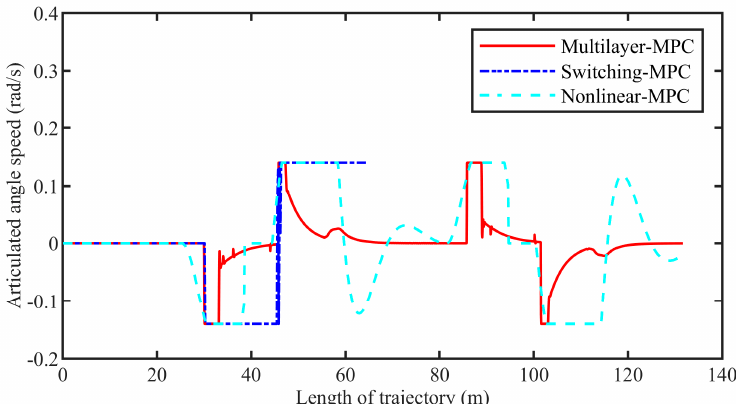
Figure 6. The articulated angle of the comparison between controllers.